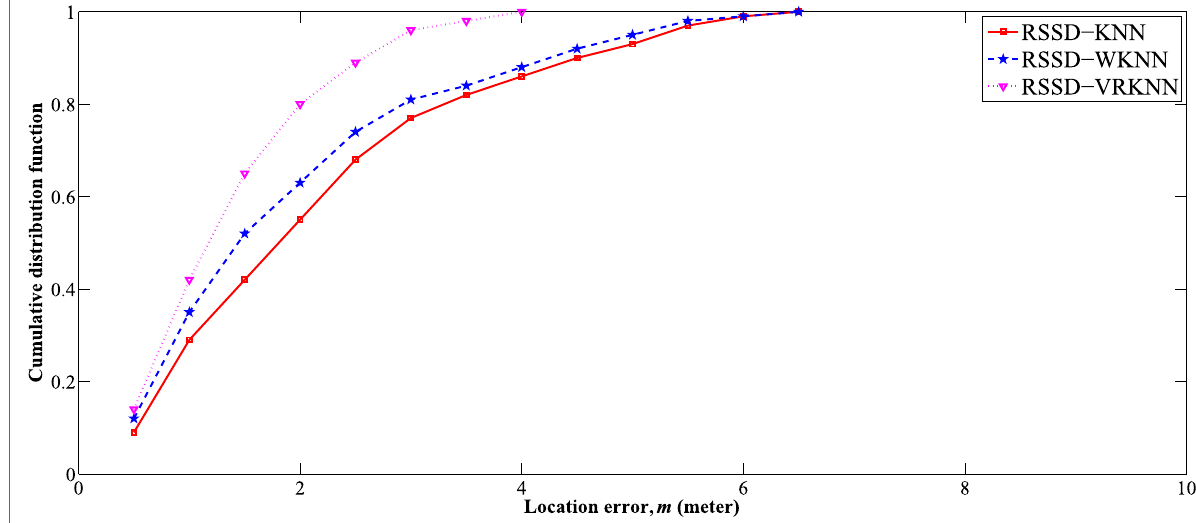
Fig.16 CDF of location errors by different algorithms. 1 GHz/20 dB database and 300 MHz/13 dB test positioning target are utilized in our